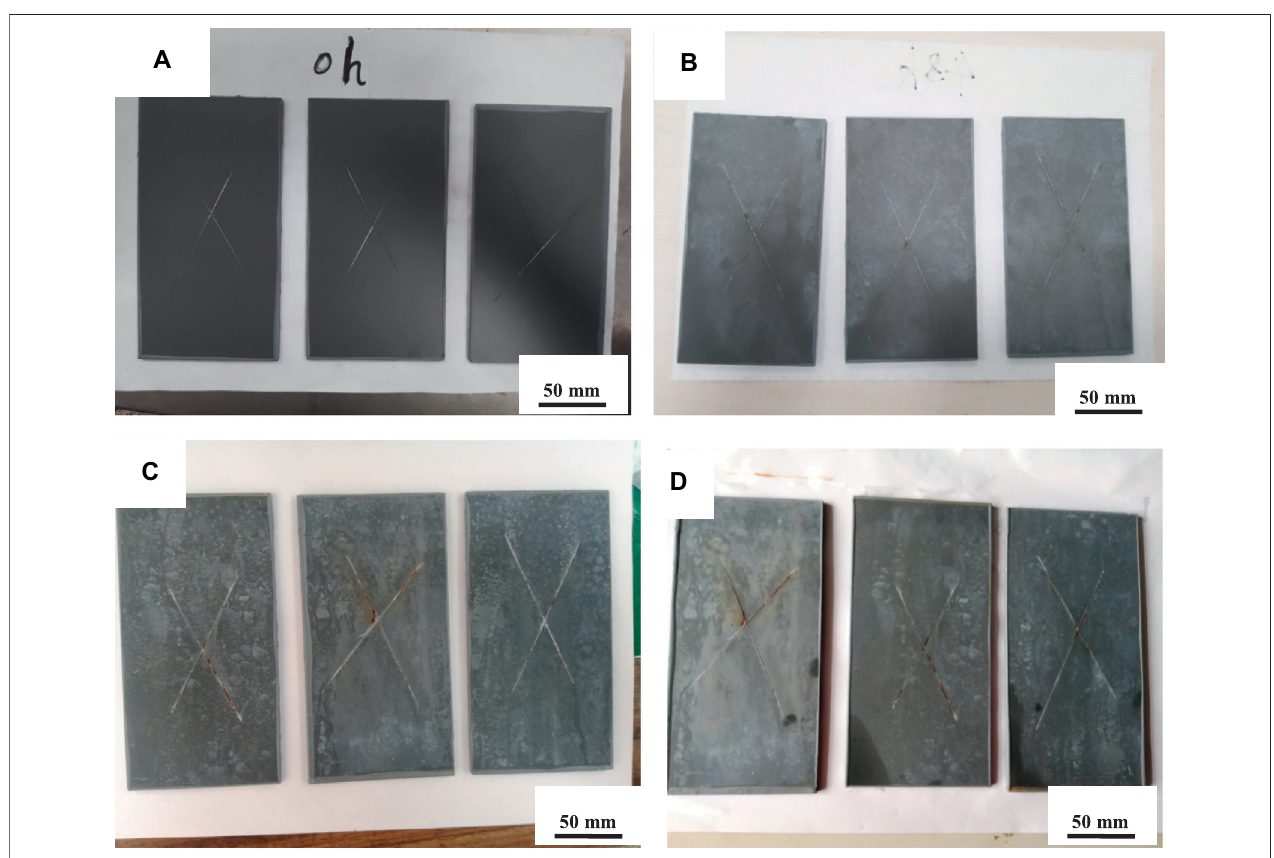
FIGURE 10 | Photographs of PA/G/EP coating immersed in salt spray chamber after different times. (A) : 0 h; (B) : 24 h; (C) : 120 h; (D) : 240 h.